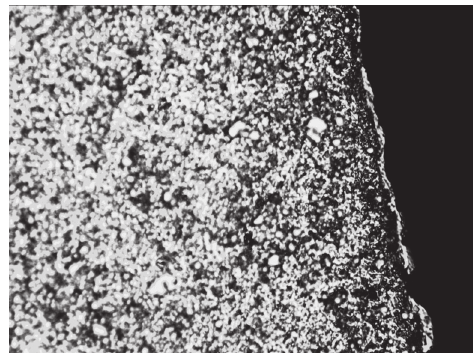
Figure 3: Optical micrograph of modified HS 6-5-2 steel surface at 150 V for 3 min, 800x.